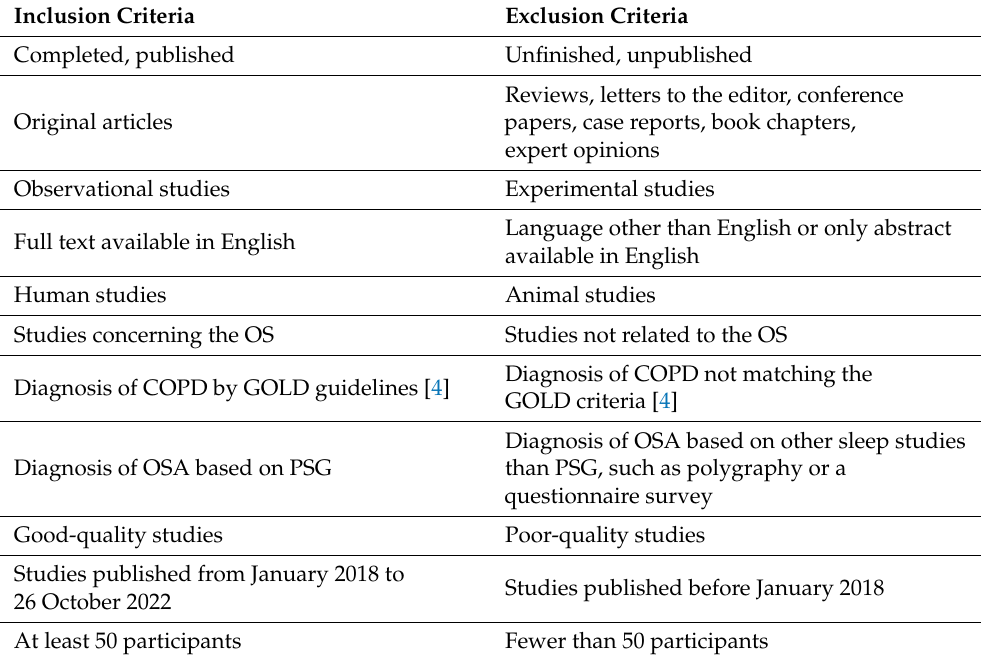
Table 1. Inclusion and exclusion criteria for the retrieved